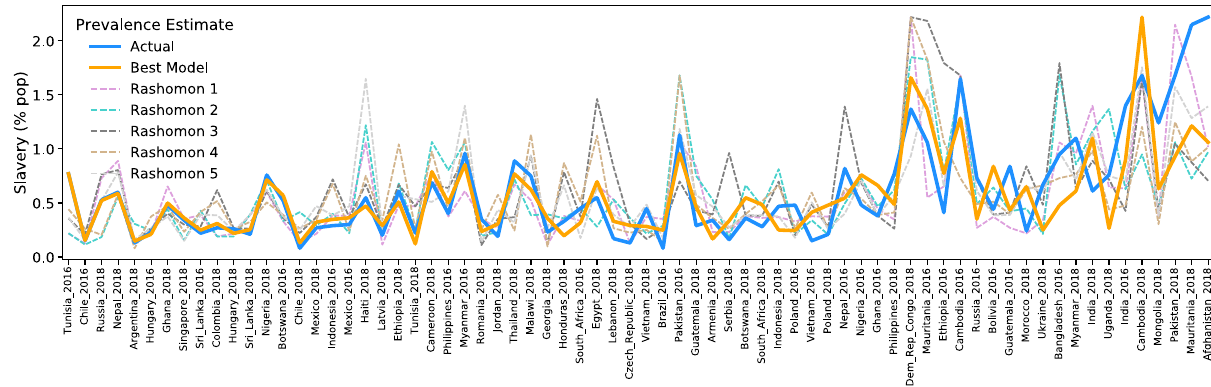
Fig. 4 The predictions of slavery prevalence (individuals enslaved as a % of the population) made by the best model and the fi ve other well performing models in the Rashomon set (see Table 2). The x -axis is ordered by the MAE between our best model and the “ actual ” prevalence as estimated by the GWP survey data.